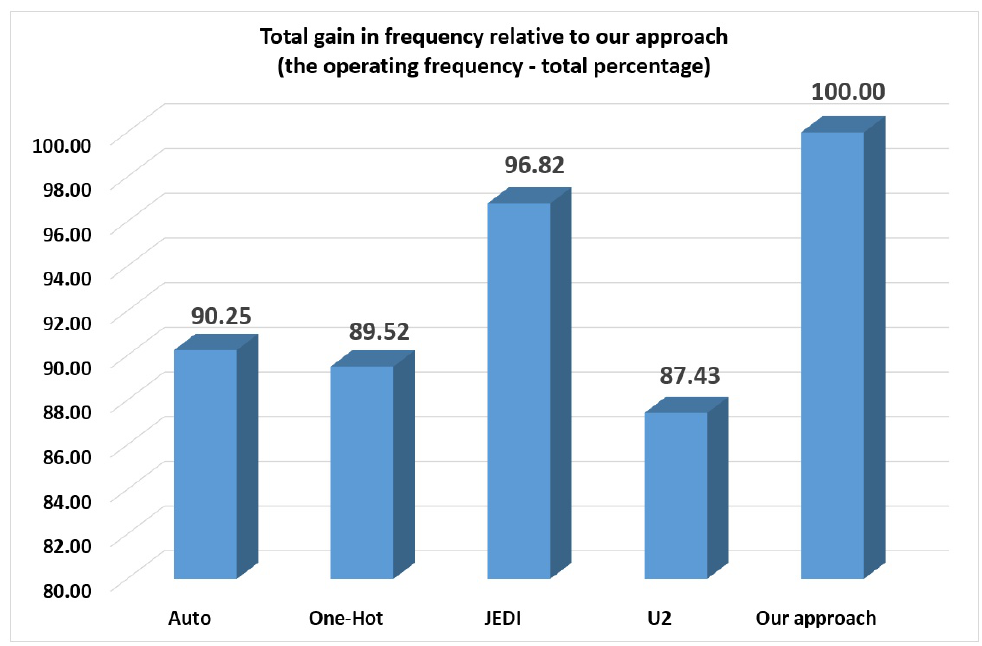
Figure 10. Total gain in frequency relative to our approach (the operating frequency—total